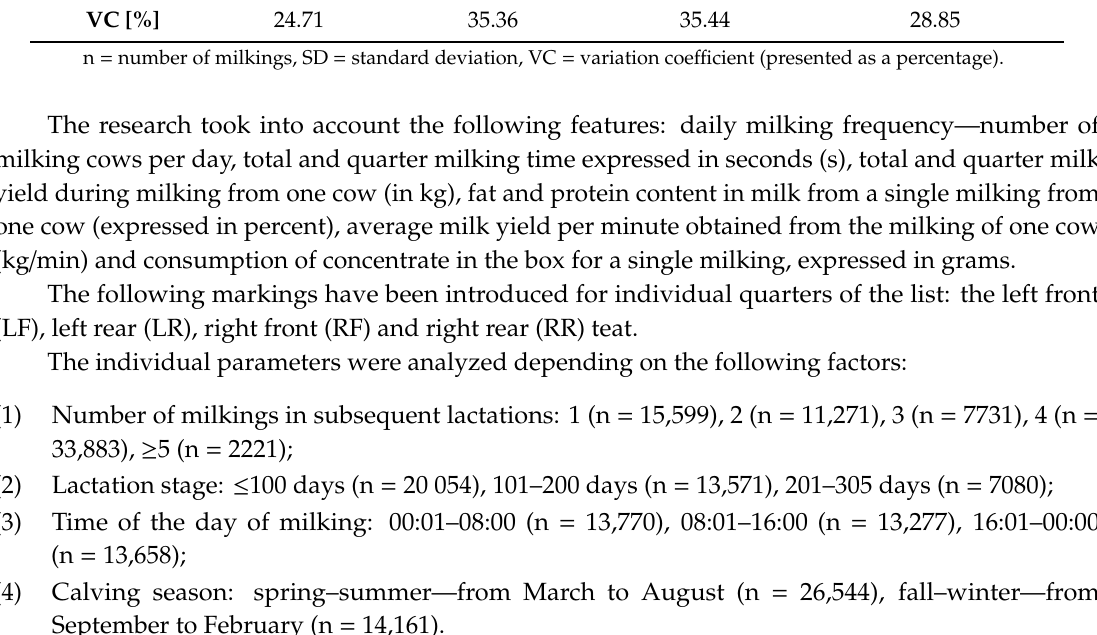
Table 1. Basic descriptive statistics of considered traits for single milkings. Milk Yield Milking Duration [kg]